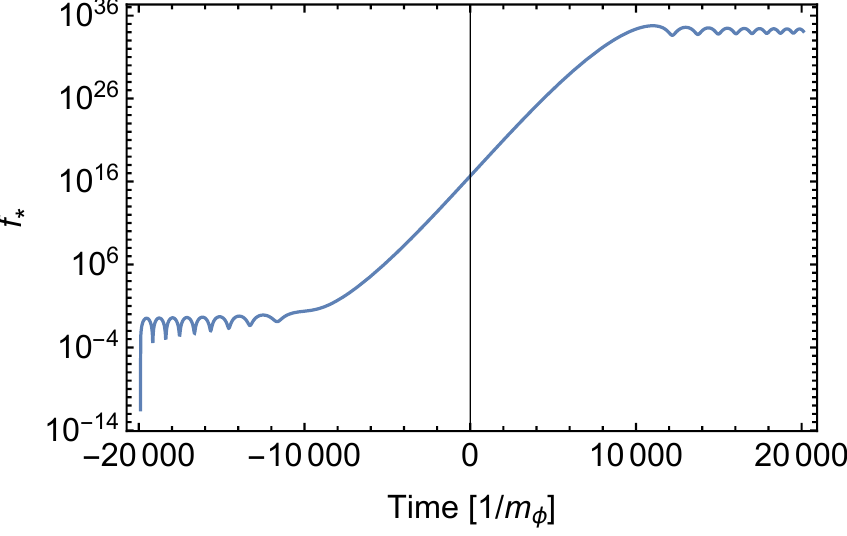
Figure 5 . Evolution of f ? , taking q = 10 − 2 and H = 5 × 10 − 3 q 2 m φ (for which t ± ’ ∓ 10000 m − 1